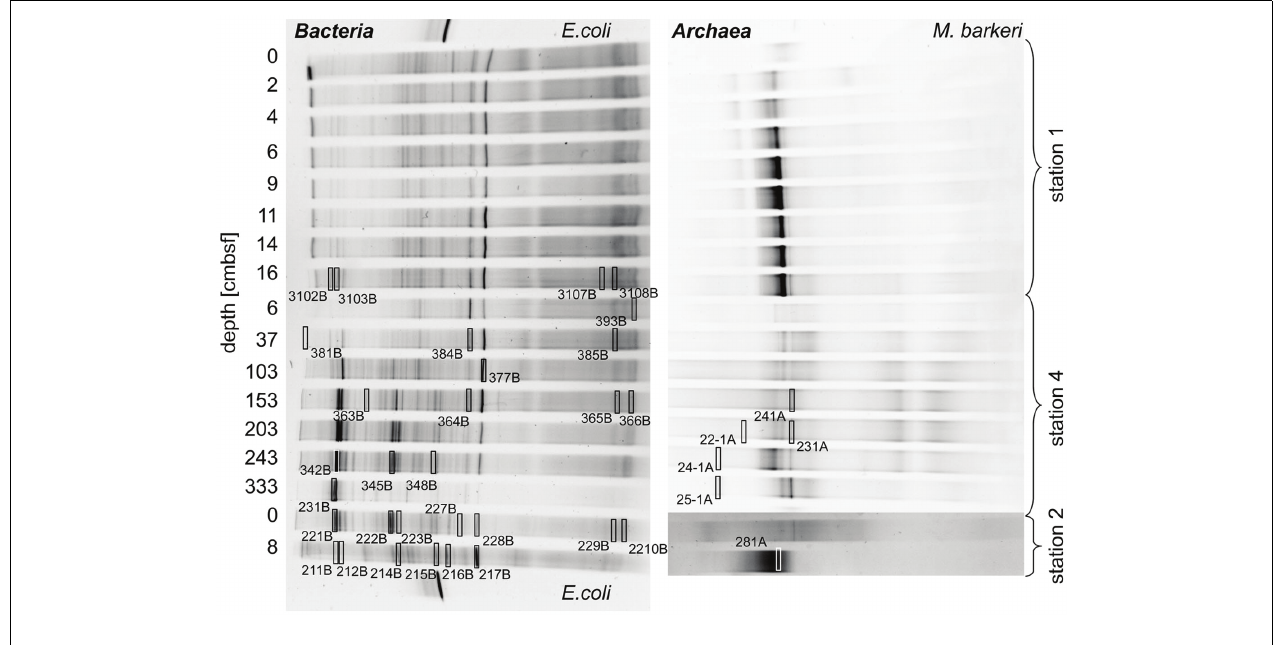
rectangles.The numbers enumerate gels, lanes, and bands and refer to the phylogenetic trees in this figure and Figure 6 . Multiple gels were prepared and bands excised from different gels could be relocated in the shown photographs. Bands resulting in unsuccessful PCR re-amplifications or sequencing reactions are not